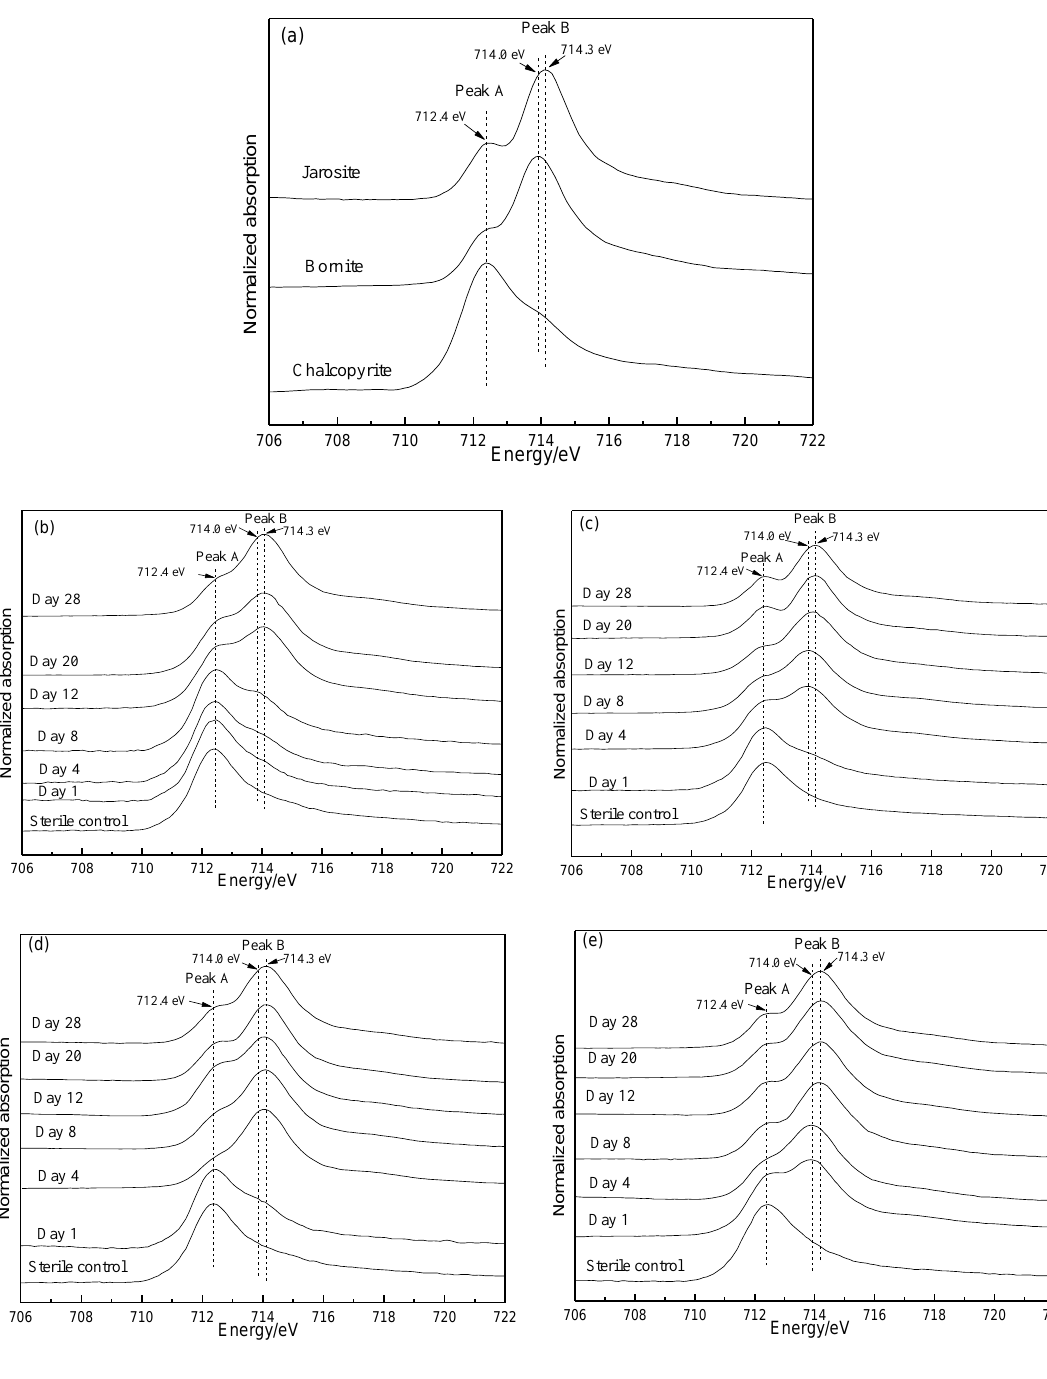
Figure 6. Normalized Fe L-edge X-ray absorption near edge structure (XANES) spectra of reference iron-containing compounds ( a ), chalcopyrite bioleached by mesophilic culture from day 1 to day 28 and in the sterile control at 30 ◦ C on day 28 without Ag + ( b ) and with 0.3% of Ag + ( c ) and the spectra of chalcopyrite bioleached by thermophilic culture from day 1 to day 28 and in the sterile control at 48 ◦ C on day 28 without Ag + ( d ) and with 0.3% of Ag + ( e